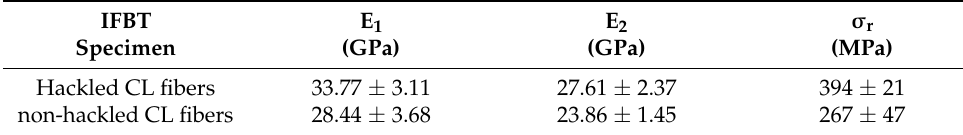
Table 4. Tensile properties of IFBT